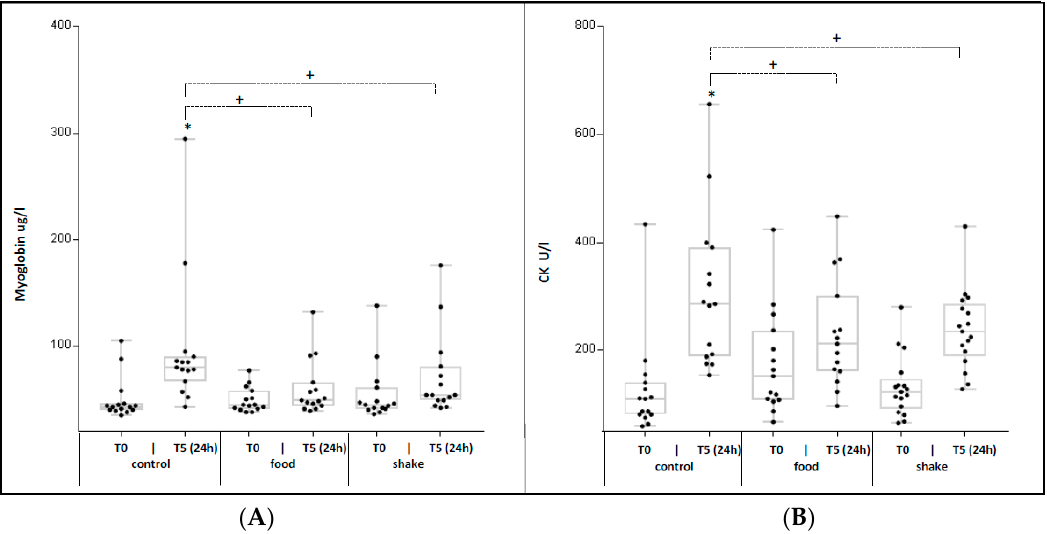
Figure 5. Effects of protein/carbohydrate uptake via food and shake on serum creatine kinase (CK) and myoglobin (Myo) concentrations, immediately after exercise, and 24 h after exercise. Shown are mean individual serum concentrations Myo ( A ) and CK ( B ). Mean of all individuals ± SD. * = p ≤ 0.05 shows statistically significant differences between marked time point and respective t0 value. + = p ≤ 0.05 show statistically significant differences between marked groups.